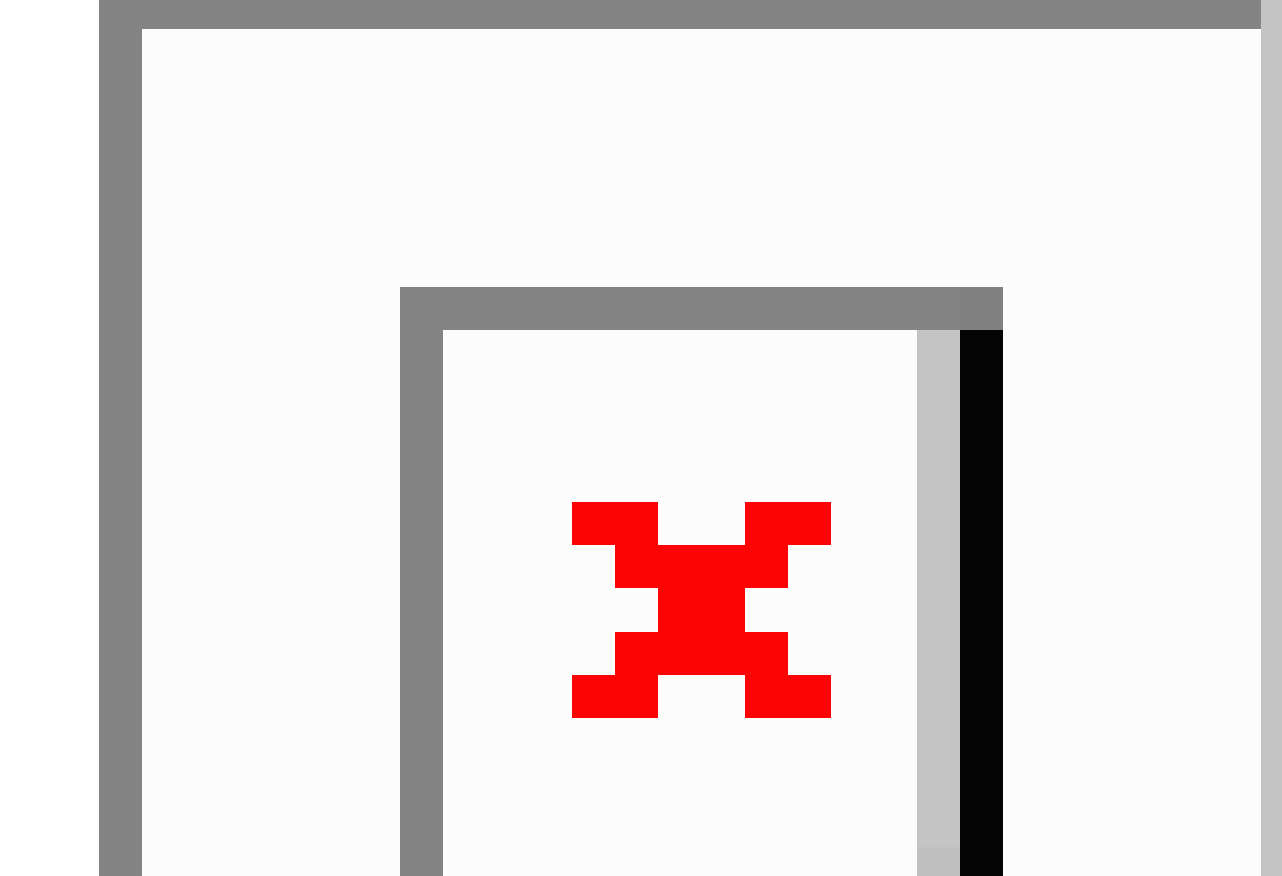
Figure 6. Negative attitude trends by year (for six